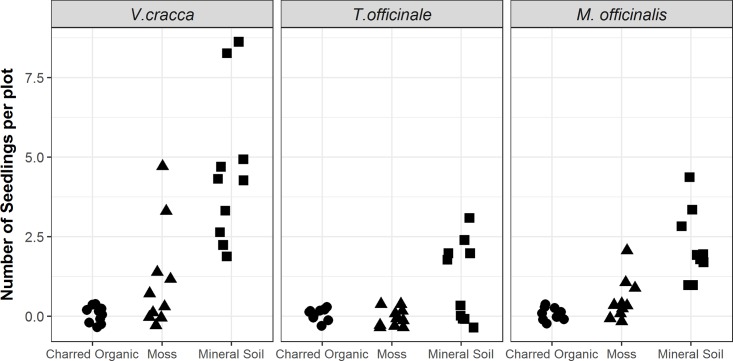
Seedling counts of V.cracca, T.officinale, and M.officinalis from germination trials on charred organic, moss, and mineral soil substrates within a burned forest (n = 10 plots).Each plot was seeded with 10 seeds of the assigned species. Note points are slightly offset for visualization.